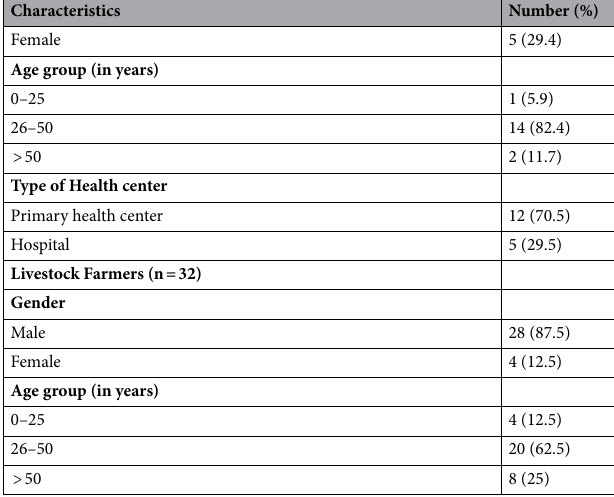
Table 1. Demographics characteristics of